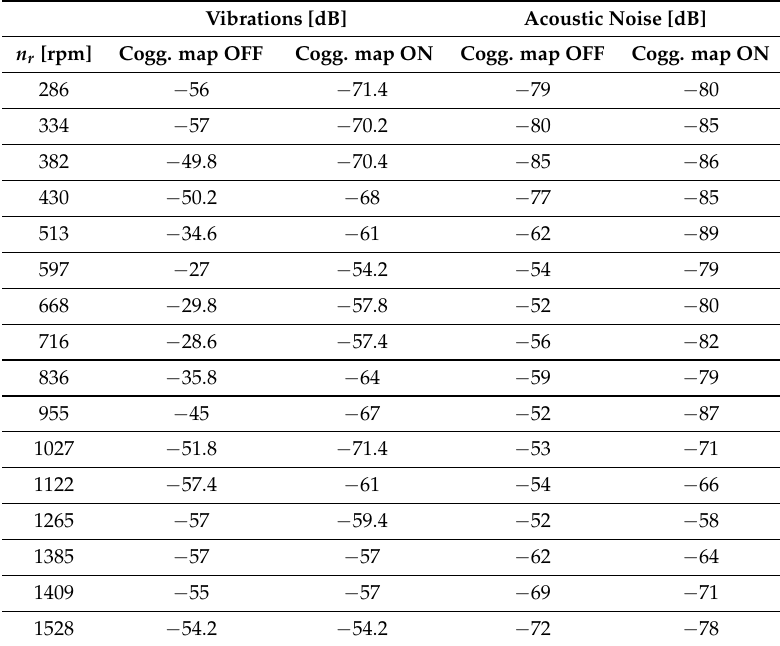
Table 2. Acoustic noise and vibrations for 2 f e curve vs. mechanical speed n r .